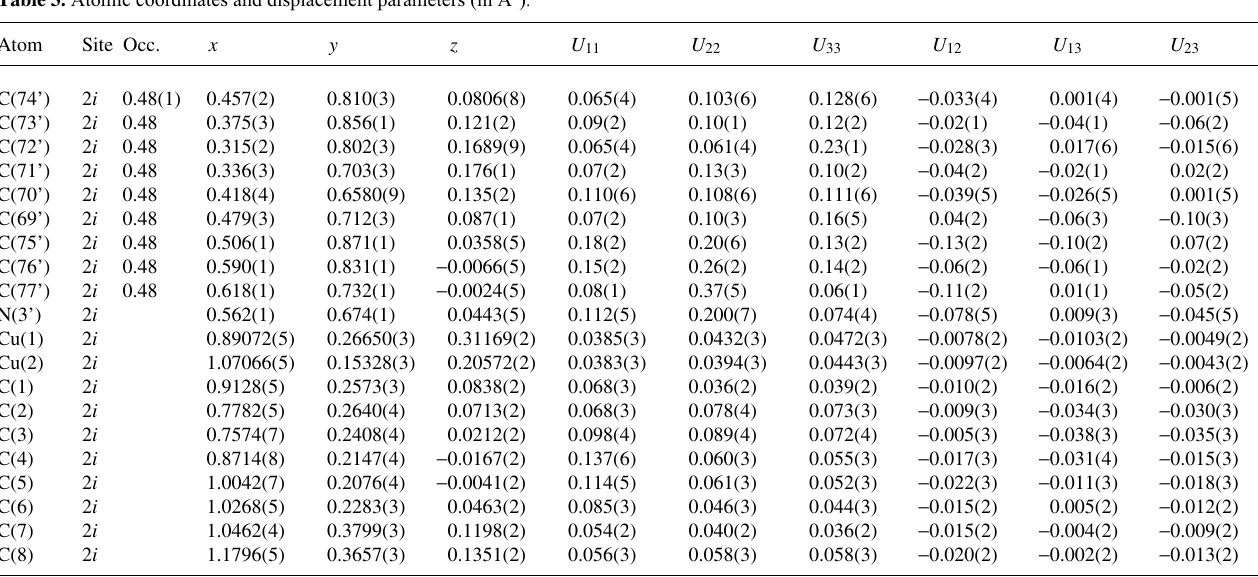
Table 3. Atomic coordinates and displacement parameters (in Å 2 ) .